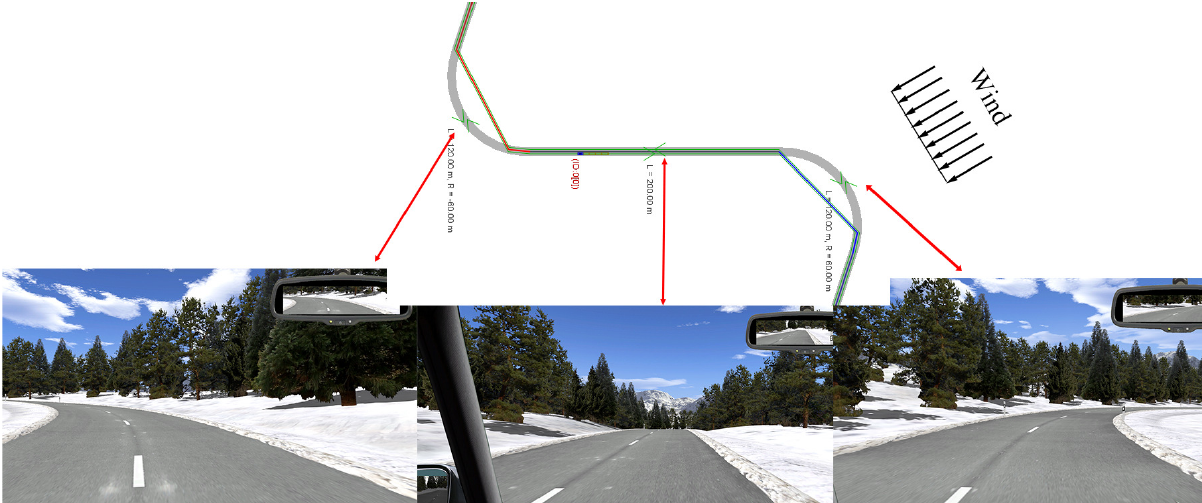
Figure 17. The scenario of the driving simulator experiments.